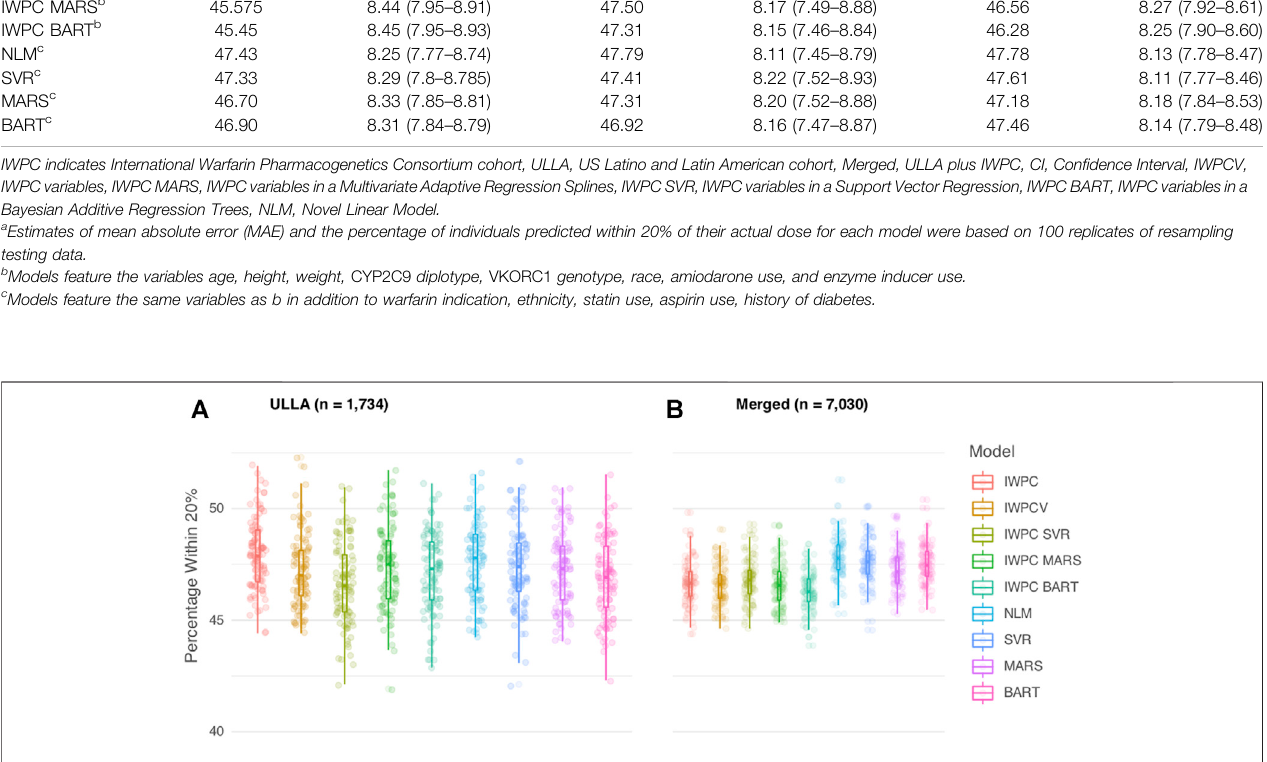
Frontiers in Pharmacology |